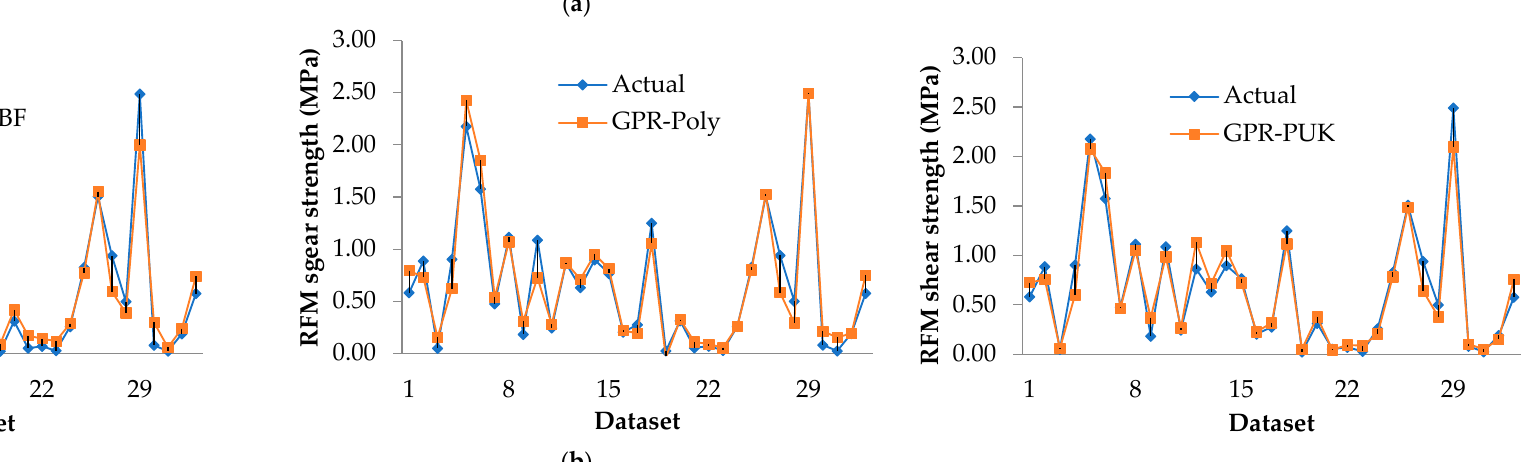
Figure 3. Comparison of the results in the testing dataset of the various kernel function-based Gaussian process regression (GPR) models ( a ) measured vs. predicted RFM shear strength, ( b ) showing the accuracy of the models in predicting RFM shear strength.